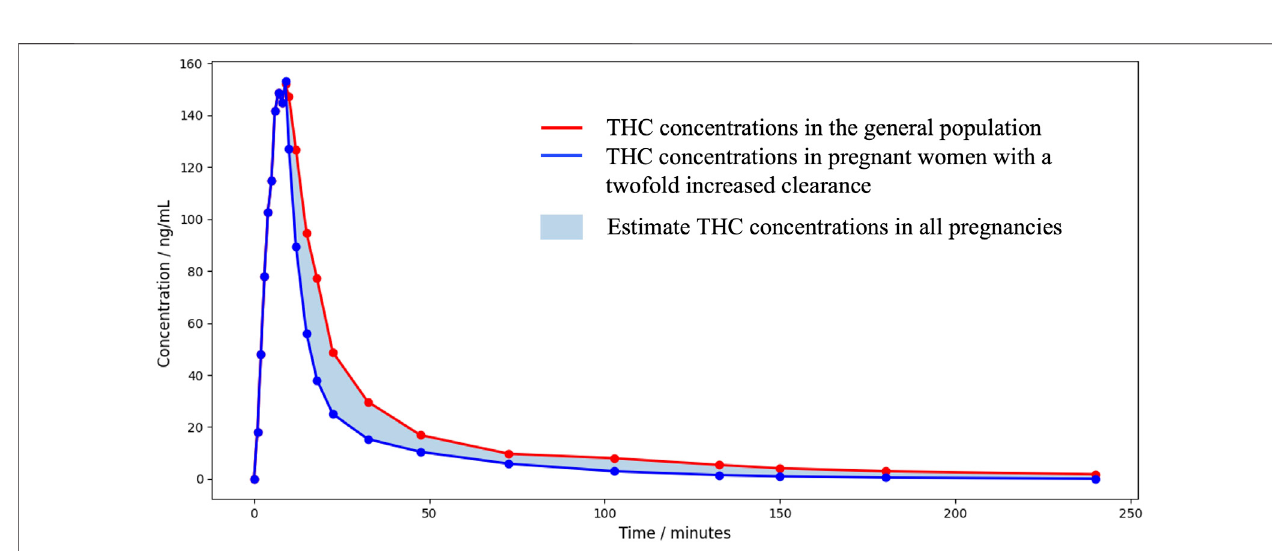
FIGURE 4 | Area of theoretical THC concentrations in pregnant women over 3 h after a single 3.55% THC marijuana cigarette.